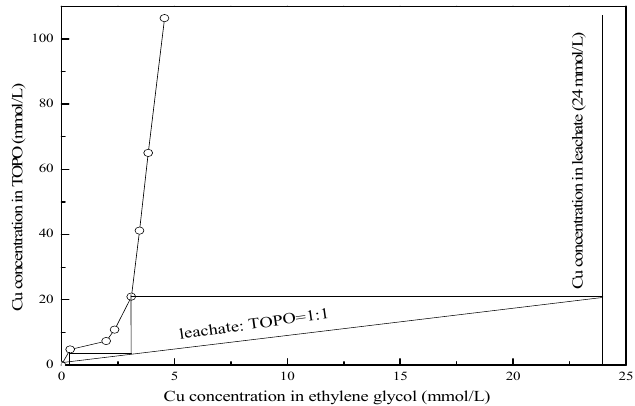
Figure 10. A McCabe–Thiele plot for Cu extraction with 1 mol/L TOPO.